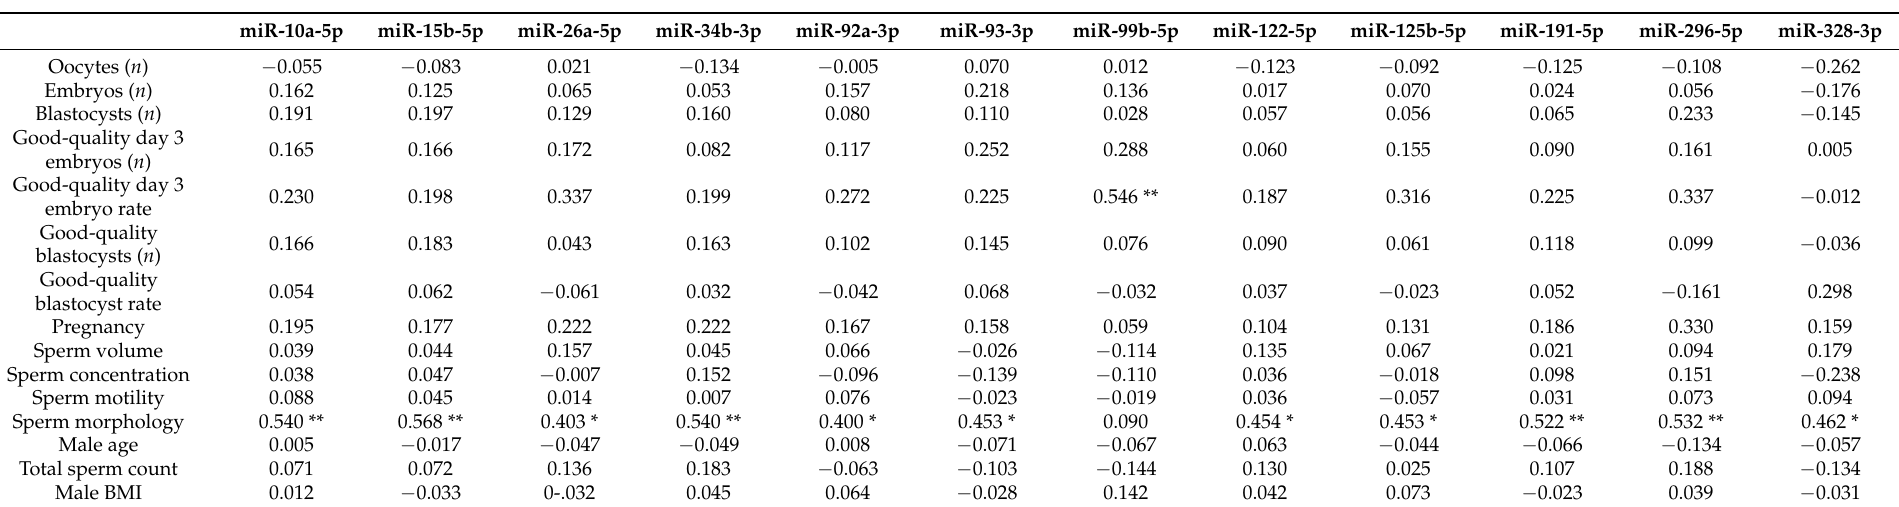
Table 4. Spearman’s correlation matrix of associations between selected variables of the IVF/ICSI cycle outcome, basic parameters of semen quality and miRNA expression levels in